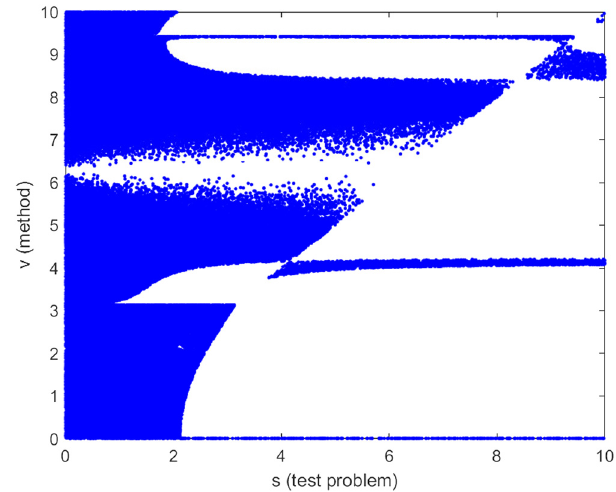
Figure 4: New method stability